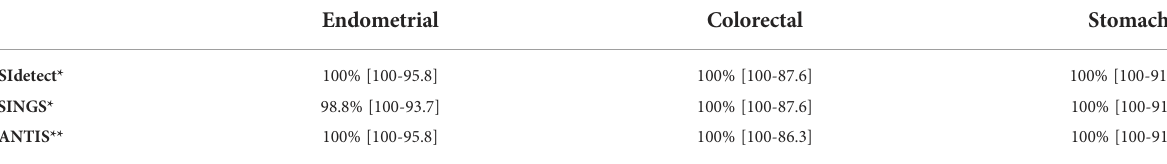
TABLE 2 Sensitivity at 95% speci fi city for different algorithms when considering restricted homopolymer set in endometrial, colorectal and stomach